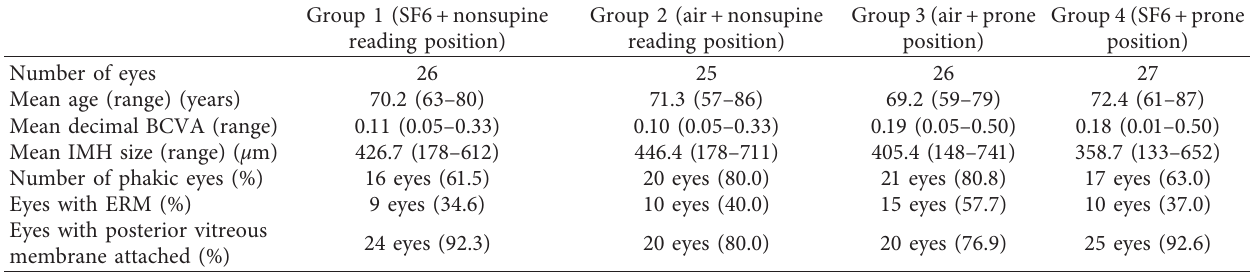
Table 1: Preoperative characteristics of the operated patients in each individual group. Group 1 (SF6 +nonsupine